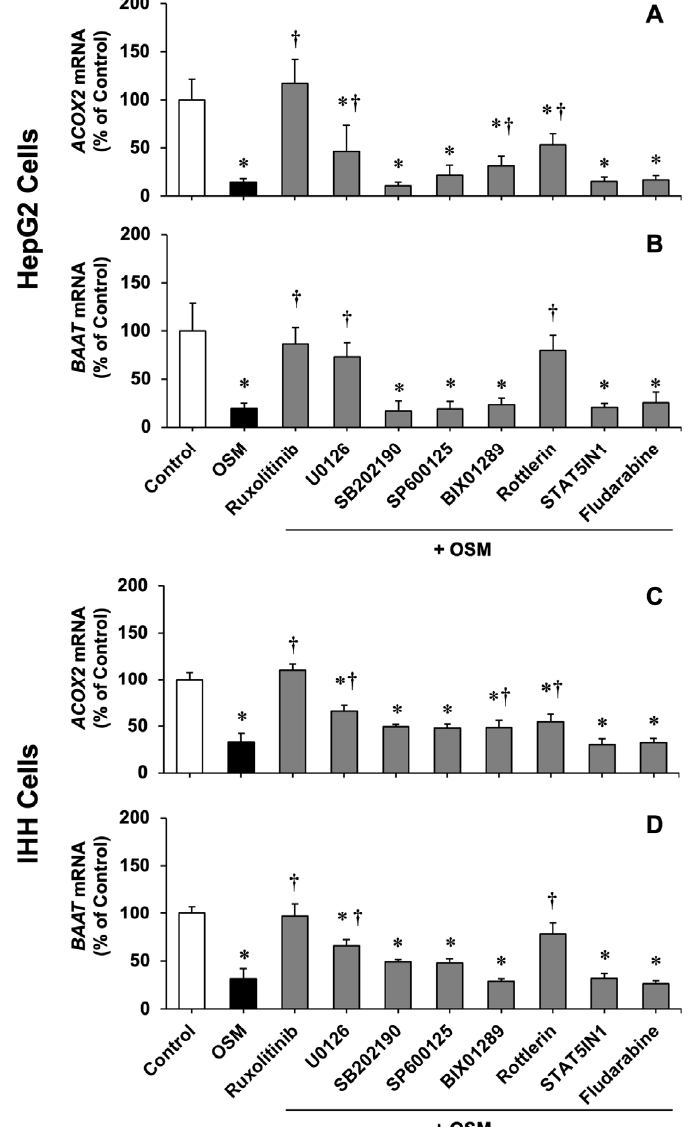
Figure 2. Relative mRNA levels, determined by RT-qPCR, of ACOX2 ( A , C ) and BAAT ( B , D ) in HepG2 ( A , B ) and IHH ( C , D ) cells, which were incubated with 25 ng/mL oncostatin M (OSM) alone or with 0.5 µ M ruxolitinib (JAK inhibitor), 5 µ M U0126 (MEK1/2 inhibitor), 5 µ M SB202190 (p38 MAPK inhibitor), 5 µ M SP600125 (JNKs inhibitor), 10 µ M BIX01289 (MEK5 inhibitor), 10 µ M rottlerin (PKC δ inhibitor), 50 µ M STAT5IN1 (STAT5 inhibitor), or 10 µ M fludarabine (STAT1 inhibitor) for 6 h. Results (mean ± SD) from six determinations carried out in three different cultures are expressed as a percentage of values found in untreated cells (Control). *, p < 0.05, as compared with Control by paired t -test. †, p < 0.05, as compared with cells treated only with OSM by paired t